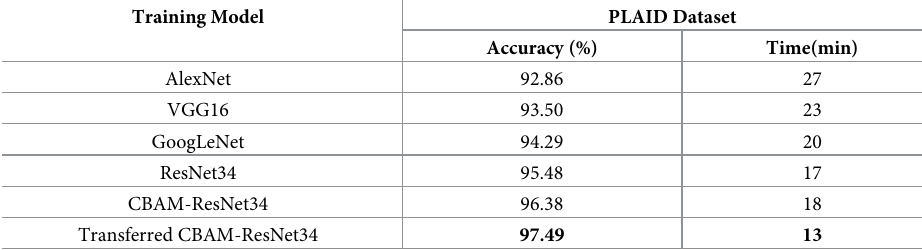
Table 2. Comparison of identification accuracy and training time between different training models on the PLAID dataset.